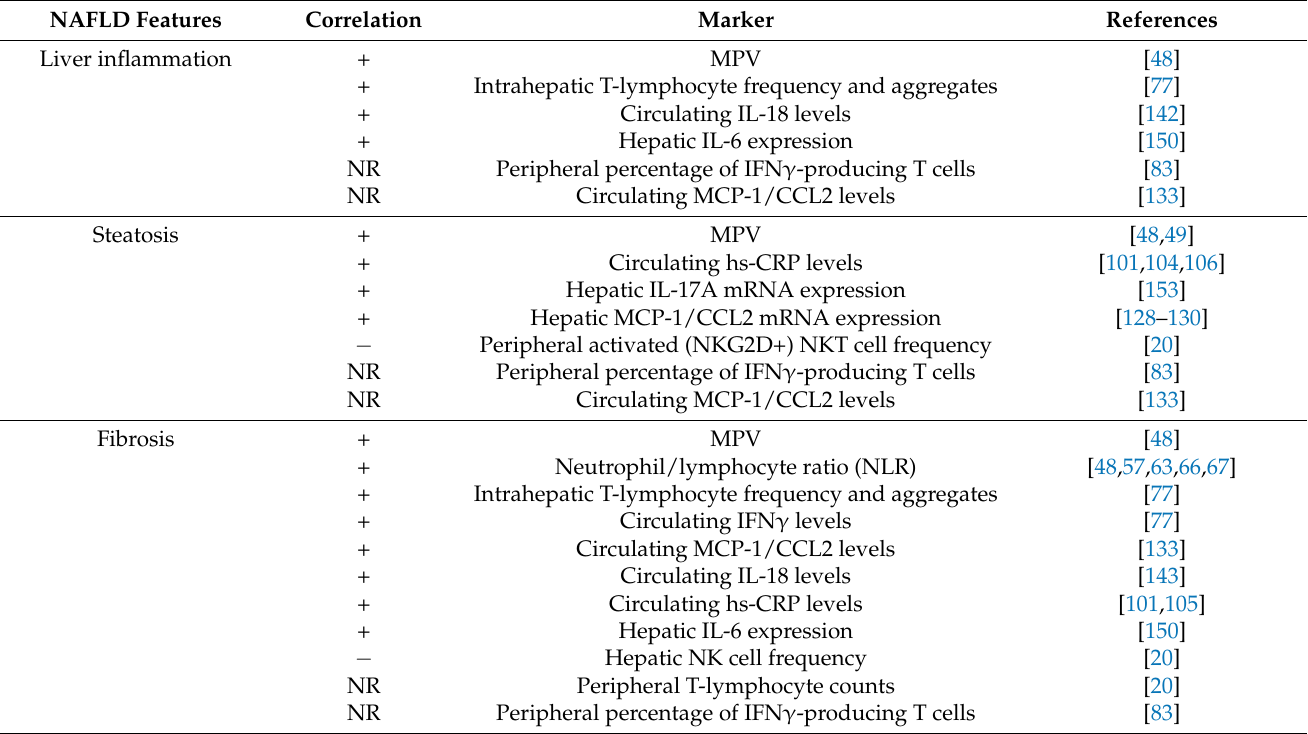
Table 1. Correlations between NAFLD features and cellular or soluble